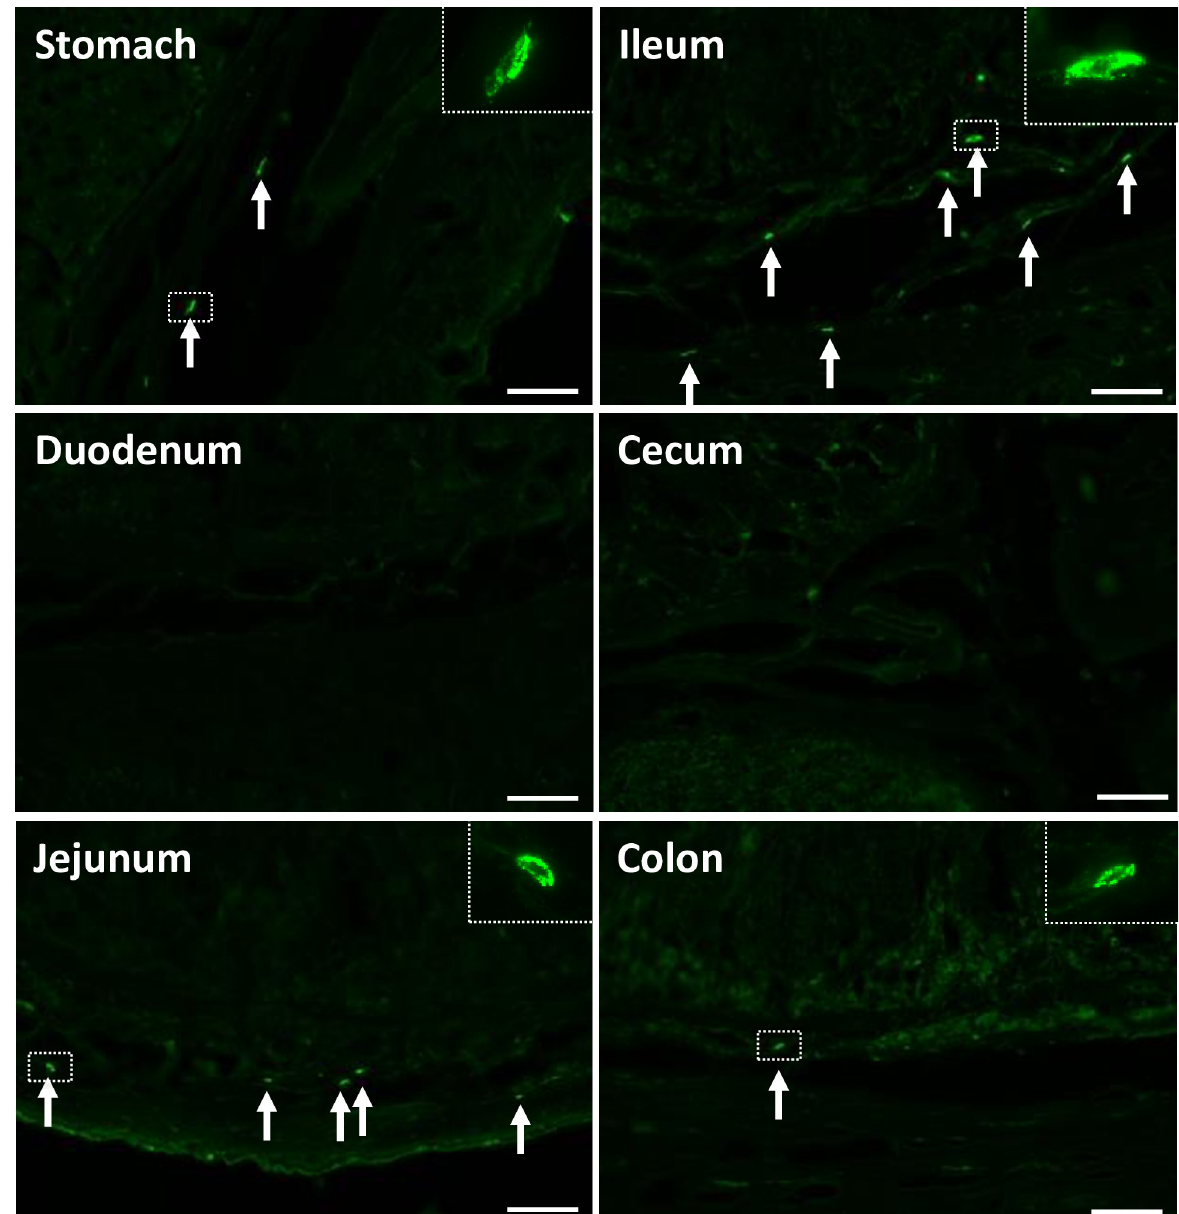
Fig 2. SEA binds with submucosal cells in the GI tract. GI tissues (stomach, duodenum, jejunum, ileum, cecum and colon) were obtained from a common marmoset. Frozen tissues were sectioned (10 μ m) and incubated with SEA (1.0 μ g/ml) for 60 min at room temperature. After washing the sections with PBST, the sections were stained for SEA using rabbit anti-SEA antibody and Alexa 488-conjugated goat anti-rabbit IgG. Magnification, x20. Each scale bar is equal to 50 μ m.